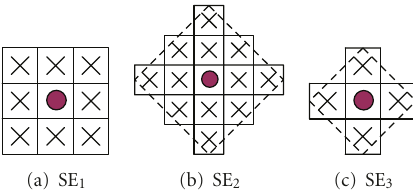
Figure 19: Structuring elements used in the progressive morpho- logical dilation.